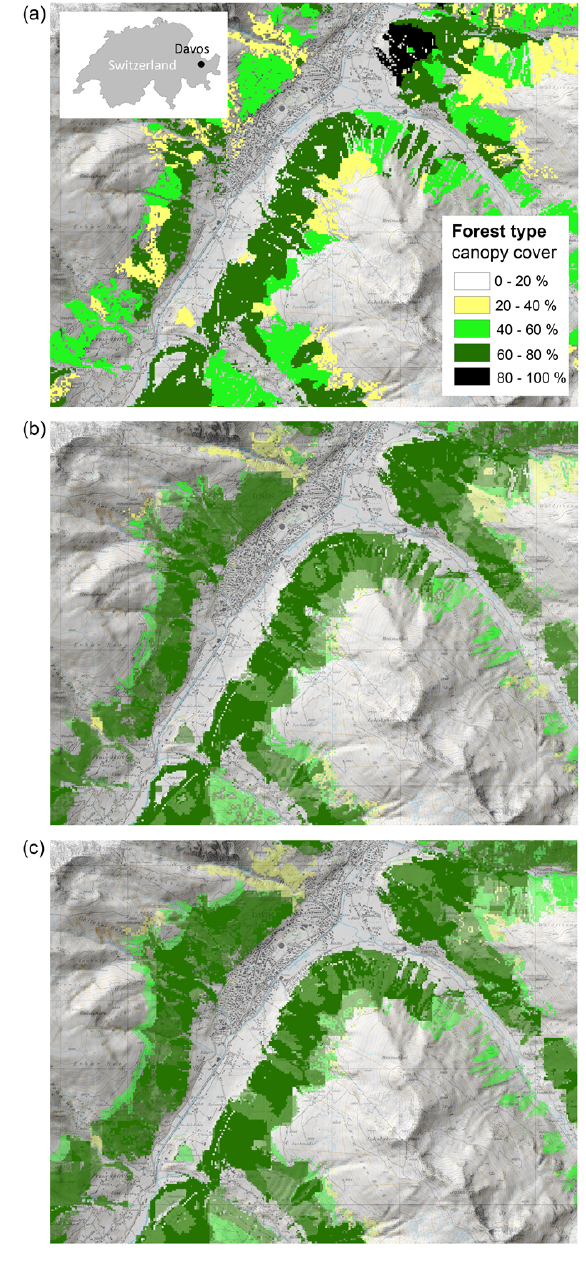
Fig. 1 . Forest types in the case study area of Davos, Switzerland in (a) the year 2000 (total forest area: 4499 ha); in (b) the year 2050 in a trend scenario (total forest area: 5085 ha); and in (c) the year 2050 in a climate scenario (total forest area: 5422 ha). In the scenario maps, high transparency indicates high uncertainties in the predictions. The inset shows the location of Davos in